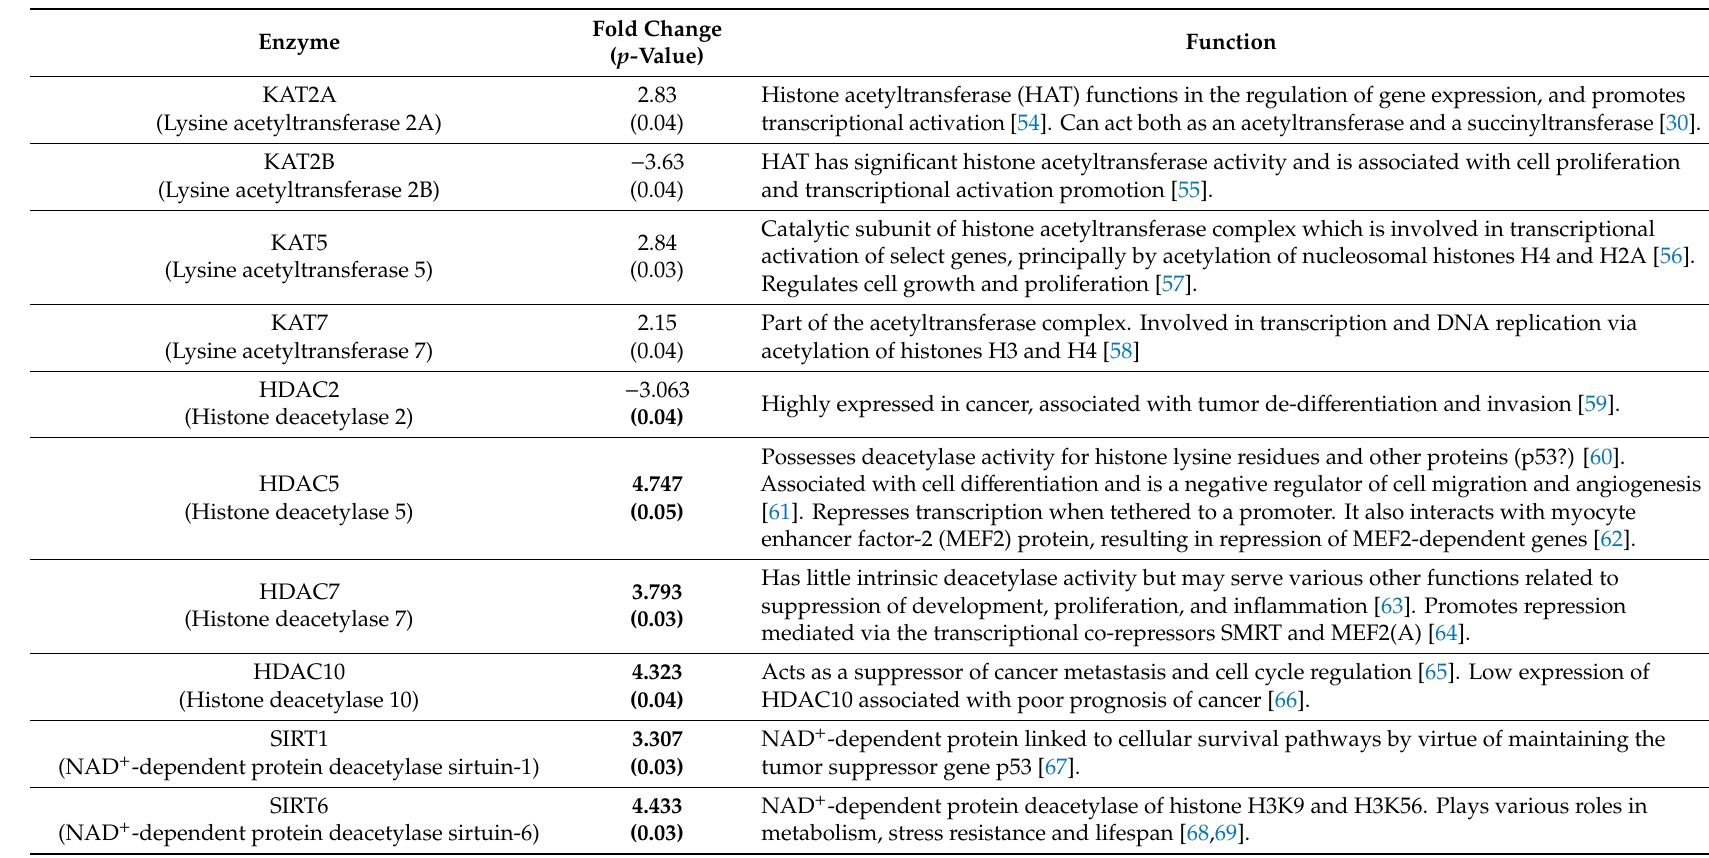
Table 1. si-VDAC1 alters the expression of epigenetics-processes-related enzymes associated with acetylation. Results are from DNA-microarray analysis and represent the fold change in expression in si-hVDAC1-TTs, relative to levels in si-NT-TTs. Selected genes associated with epigenetics are presented. Genes modified ≥ 2-fold with a false discovery rate < 0.05 are listed. For each gene, the gene symbol and name, linear fold change in expression, and p -value are indicated. Negative numbers represent